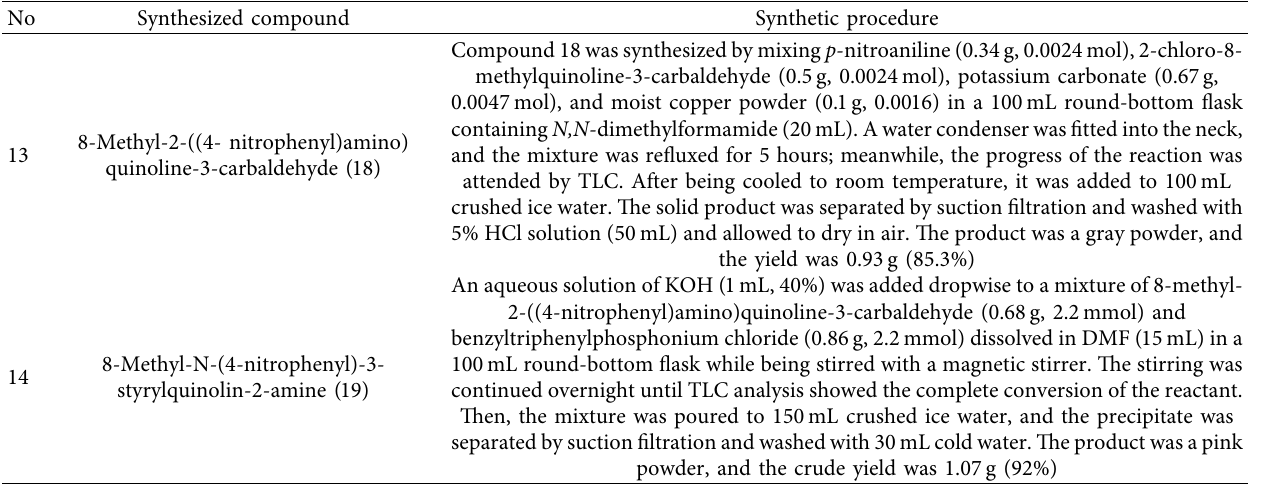
Table 5: Continued table of the synthesized compounds and their synthetic procedure. No Synthesized compound Synthetic procedure